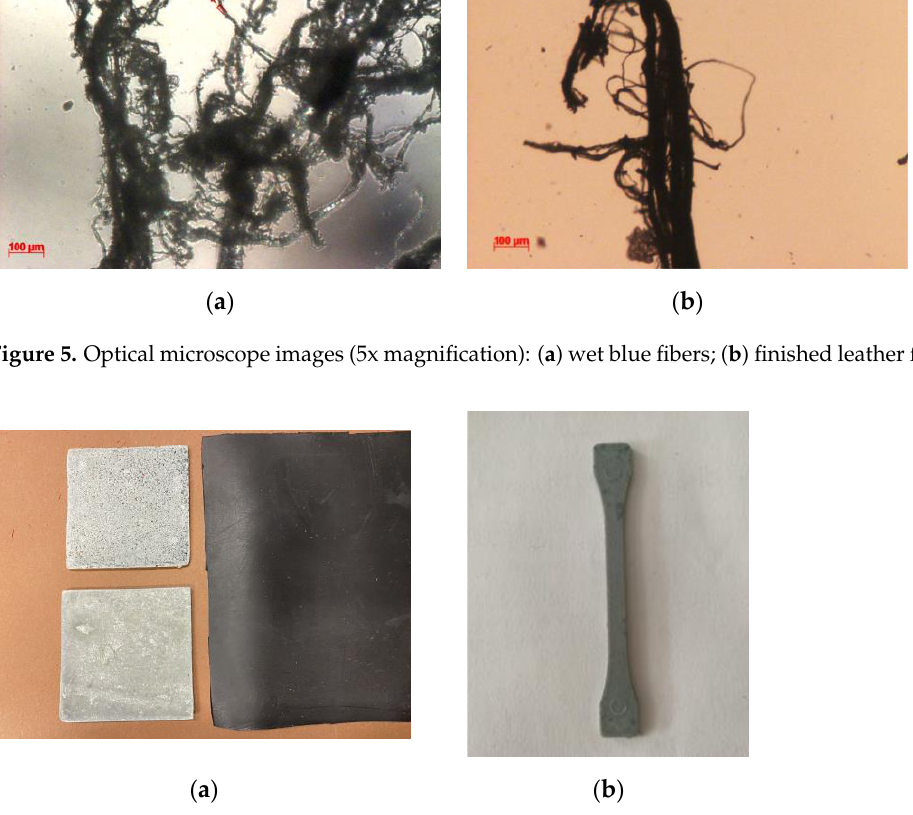
Figure 6. ( a ) Samples of composite materials of leather with different polymeric matrices prepared by compression molding; ( b ) sample of composite material of leather prepared by injection mold- ing.